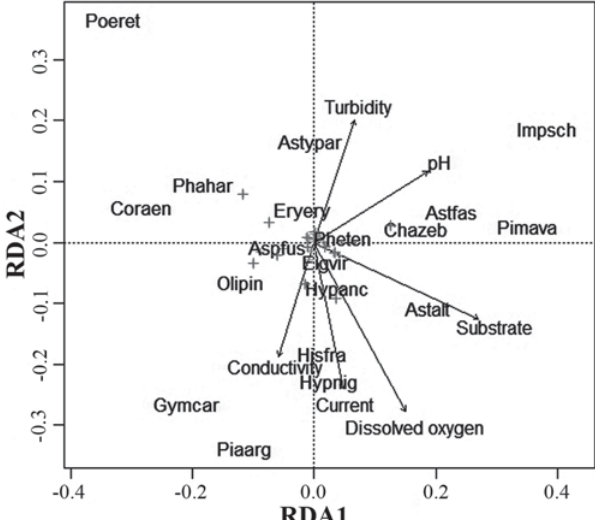
Fig. 5. Biplot of the Partial Redundancy Analysis (pRDA) on fish species composition (see abbreviations on Table 2) and abiotic variables relationships (arrows). Species with low abundance were not represented in the biplot following the option “orditorp r” in the package vegan of the software R